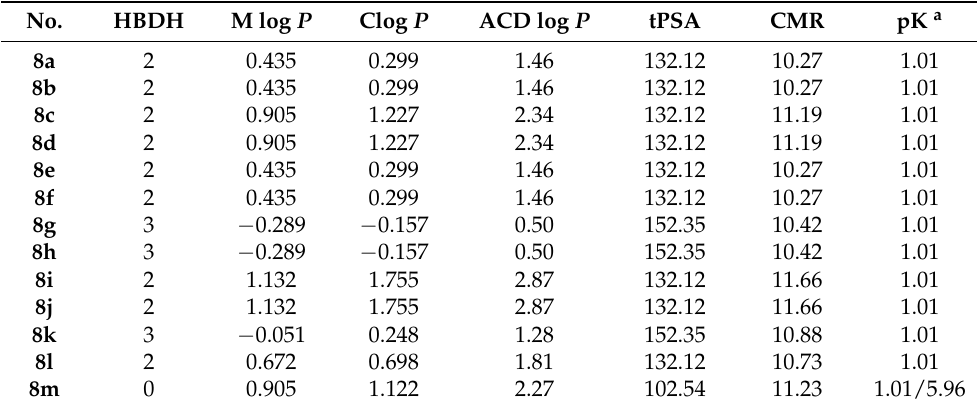
Table 6. The molecular descriptors ( a ) of the compounds calculated in silico.